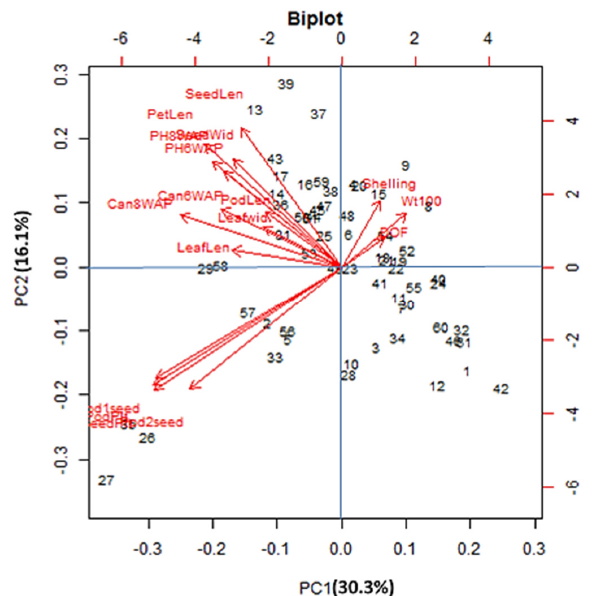
Figure 1. Biplot display of the relationship between the sixty-one Bambara groundnut accessions and seventeen quantitative variables